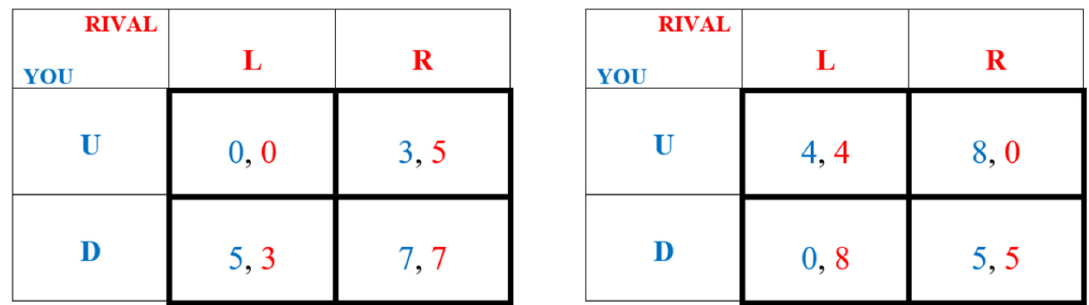
Figure 2. SuA under two best choices.